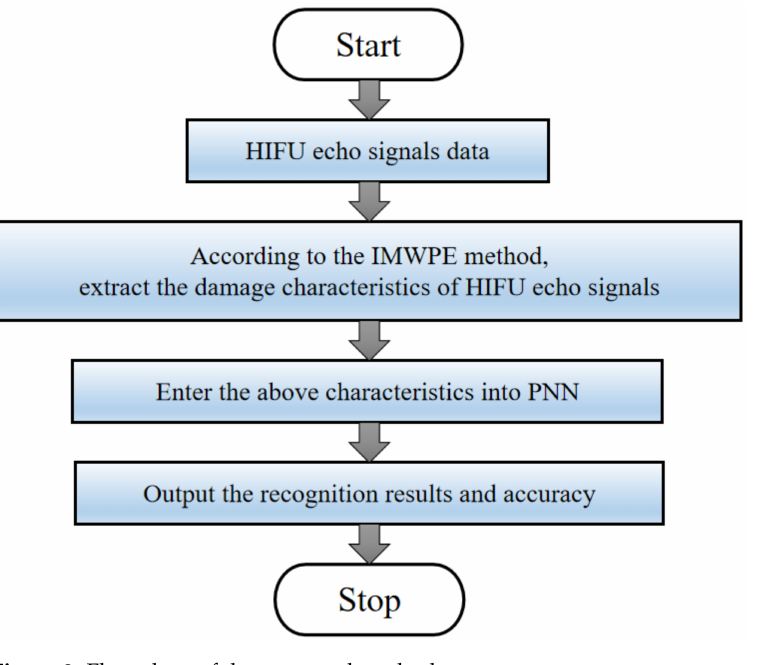
Figure 2. Flow chart of the proposed method.